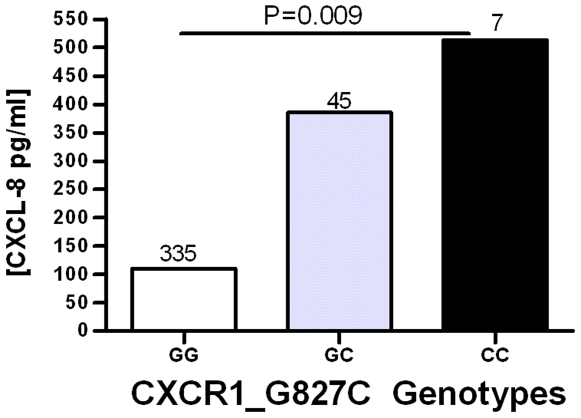
Association of a CXCR1 polymorphism with urine CXCL-8 levels in women with ASB.Urine CXCL-8 levels in women with ASB were stratified by CXCR1_G827C genotypes and analyzed by a log-additive model. The 90th percentile median values are plotted with sample size for each genotype indicated.